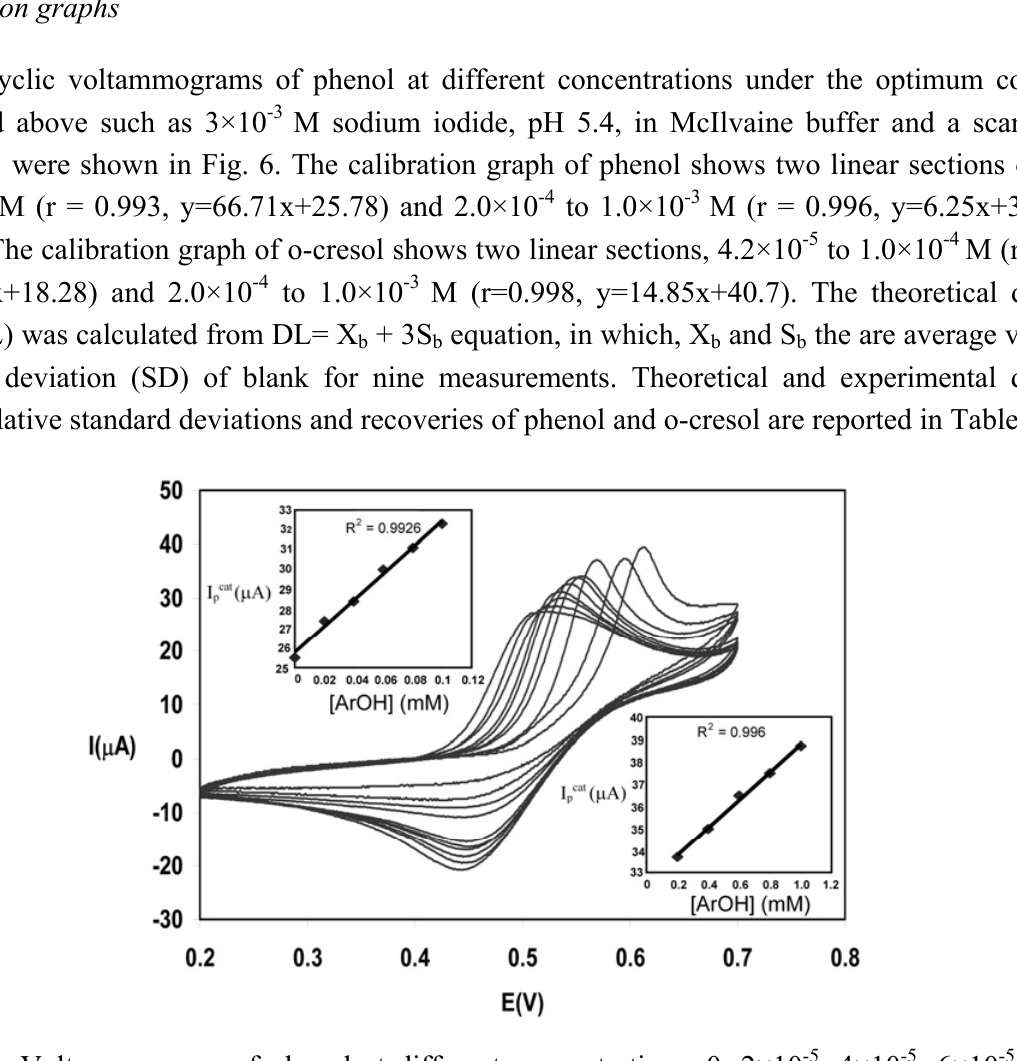
Figure 6. Voltammograms of phenol at different concentrations, 0, 2×10 -5 , 4×10 -5 , 6×10 -5 , 8×10 -5 , 1×10 -4 , 2×10 -4 , 4×10 -4 , 6×10 -4 , 8×10 -4 , 1×10 -3 M. Inset: the calibration graphs of phenol in two different concentration ranges, GC electrode, scan rate 50 mVs -1 , McIlvaine buffer (pH 5.4) and 3×10 -3 M sodium iodide. Table 1. Detection limits, relative standard deviations and recoveries of phenol and o-cresol determination by cyclic